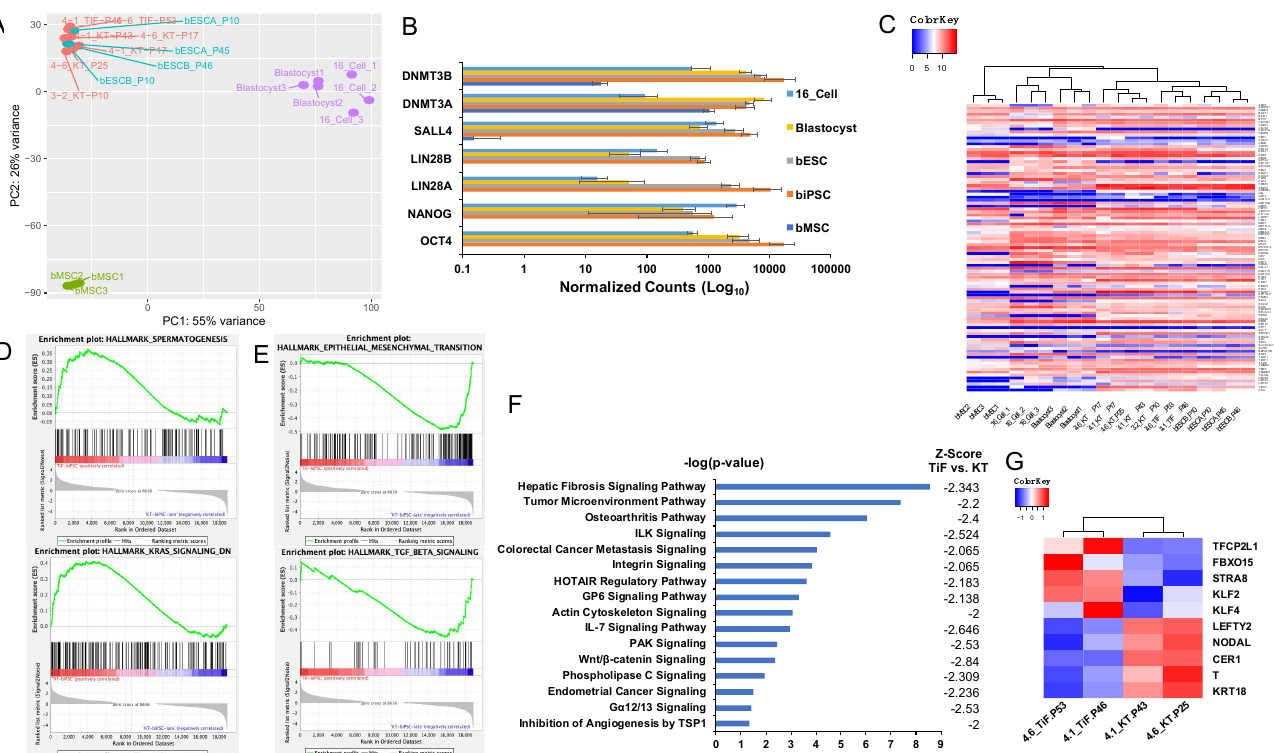
Figure 4. Transcription analysis of biPSCs. ( A ): PCA analysis of RNA-seq data from biPSCs in KT and TiF media, bESCs, and bovine embryos at the 16-cell and blastocyst stages. ( B ): Comparison of pluripotent gene expression between biPSCs, bESCs, bovine embryos, and bMSCs based on RNA-seq data. ( C ): Heatmap2 clustering analysis on 97 bovine pluripotent genes detected from RNA-seq data. ( D ): Biological processes enriched in naïve-like biPSCs by GSEA analysis. ( E ): Biological processes enriched in primed-like biPSCs by GSEA analysis. ( F ): Significantly inhibited signaling pathways in naïve-like biPSCs (in TiF medium) compared with primed-like biPSCs (in KT medium). ( G ): Heatmap2 analysis on naïve- and primed- markers for biPSCs in TiF and KT media based on RNA-seq